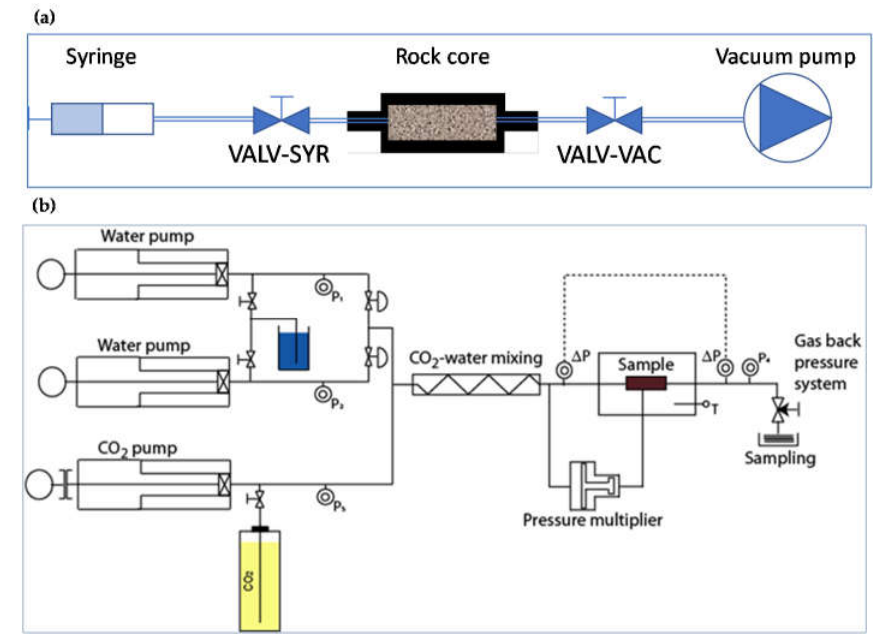
Figure 2. ( a ) Experimental setup for solgel injection in a porous rock sample. VALV-SYR corresponds to the valve that connects the syringe to the rock core, and VALV-VAC indicates the valve that connects the rock core to the vacuum pump. A heat-shrinkable sheath maintains the two valves linked to the rock sample and allows vacuum conditions in the system; ( b ) Schematic representation of the Icare Lab 1 flow-through system used to measure water permeability of the porous samples before and after solgel injection.